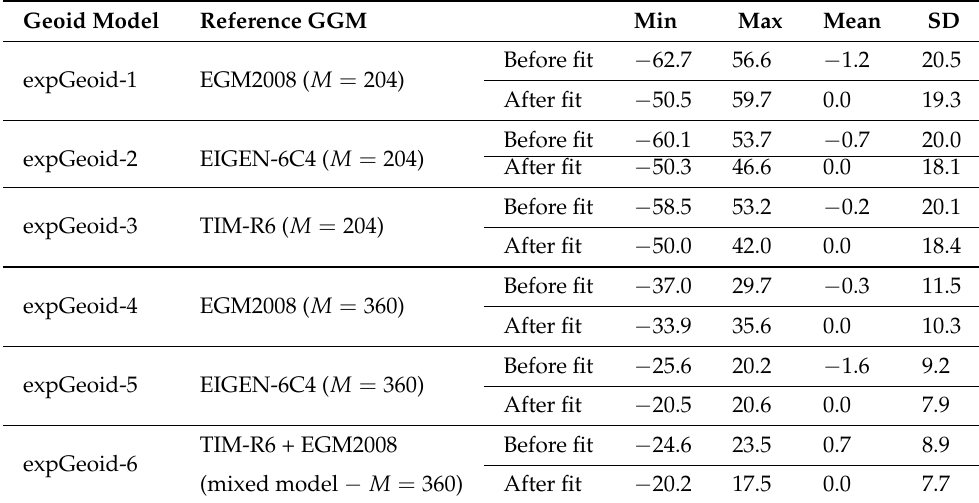
Table 3. Statistics of gravimetric geoid model accuracy computed using TIM R6, EGM2008, and EIGEN6C4 models. [unit: